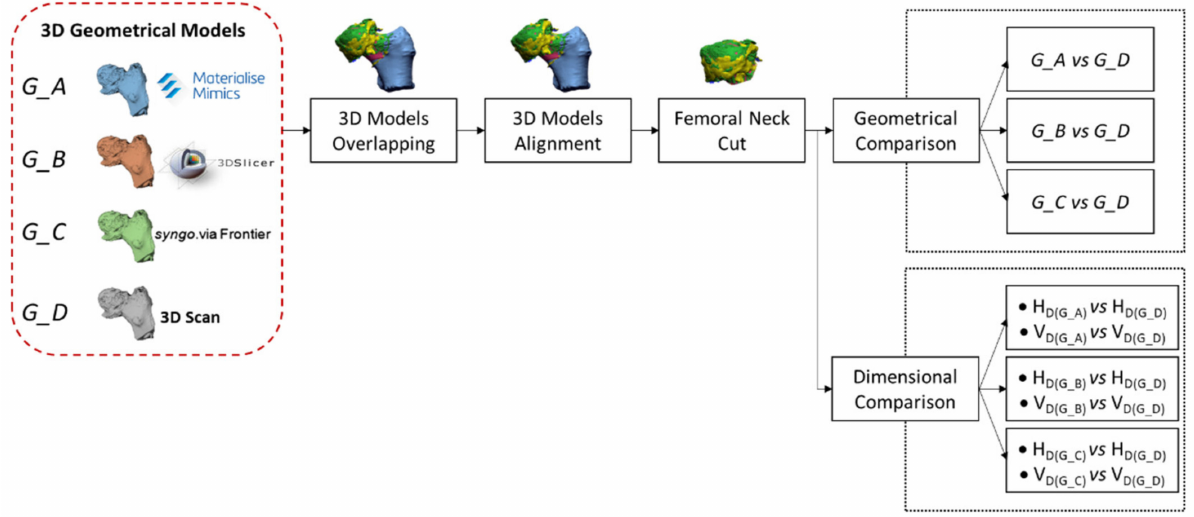
Figure 2. Pipeline’s part 2: 3D models comparison workflow. H D and V D are, respectively, the horizontal and vertical diameters of the femoral